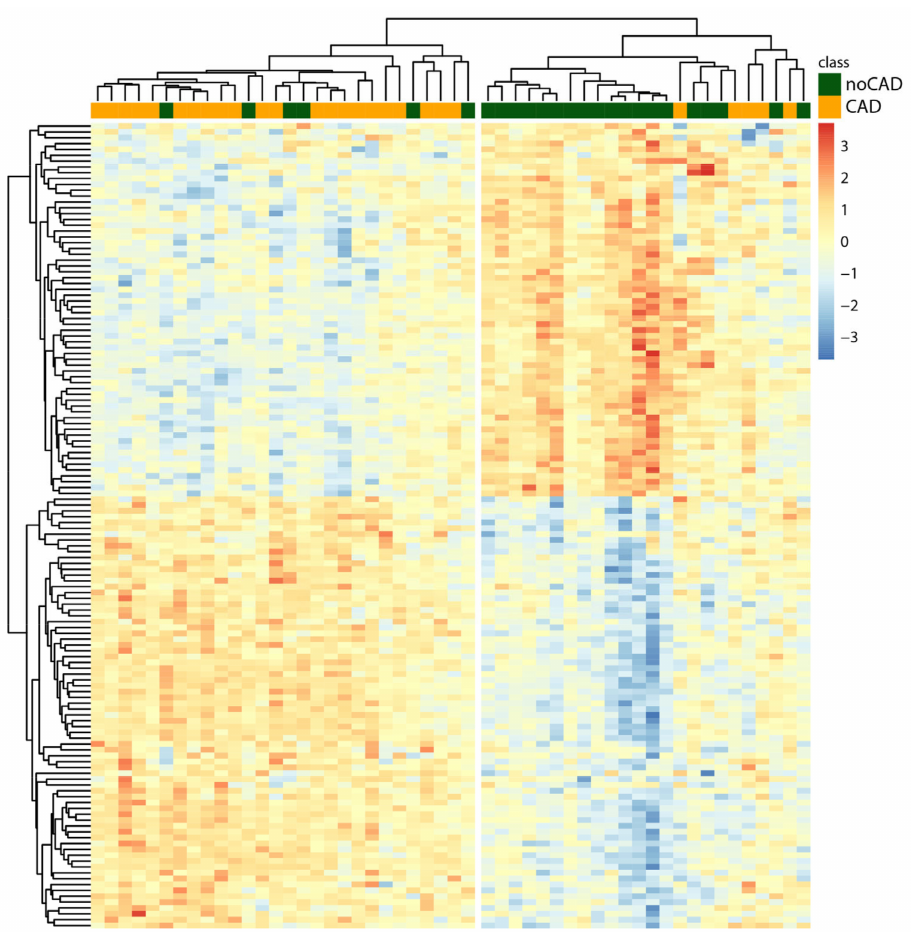
Figure 2. Heatmap visualizing hierarchical clustering results. The dendrograms show the subjects under study in the columns and the differentially expressed genes in the lines. In the heatmap, each gene is associated with a chromatic index indicating normalized expression in the sample (from bright blue = low level of expression to dark red = high level of